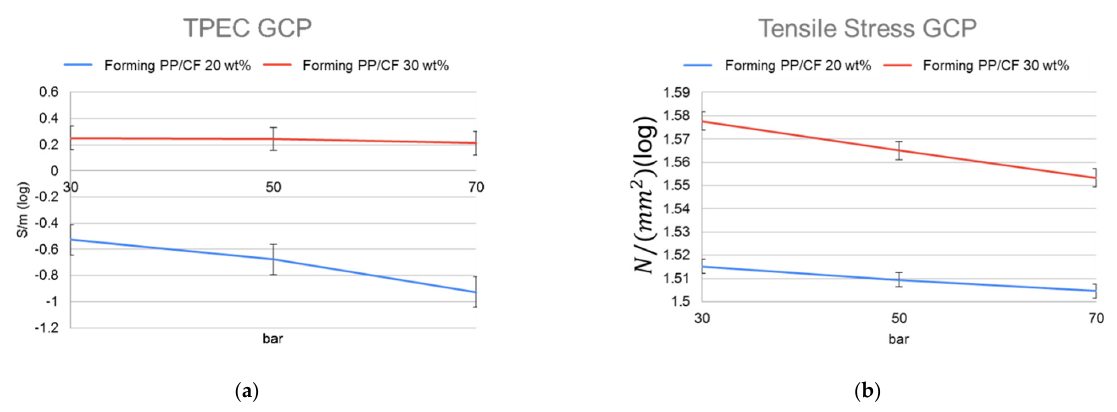
Figure 10. ( a ) TPEC and ( b ) TS of samples with different GCPs and CF contents.